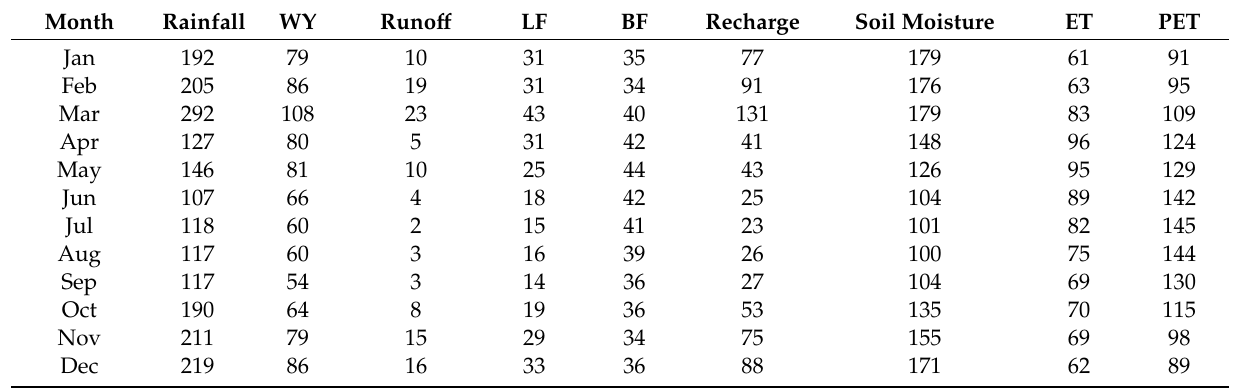
Table 5. The average monthly (2002–2014) water balance components (all values in millimeters) of the Heeia watershed. LF = lateral flow; BF = base flow; WY = water yield; ET = evapotranspiration; PET = potential evapotranspiration (except rainfall, all are SWAT